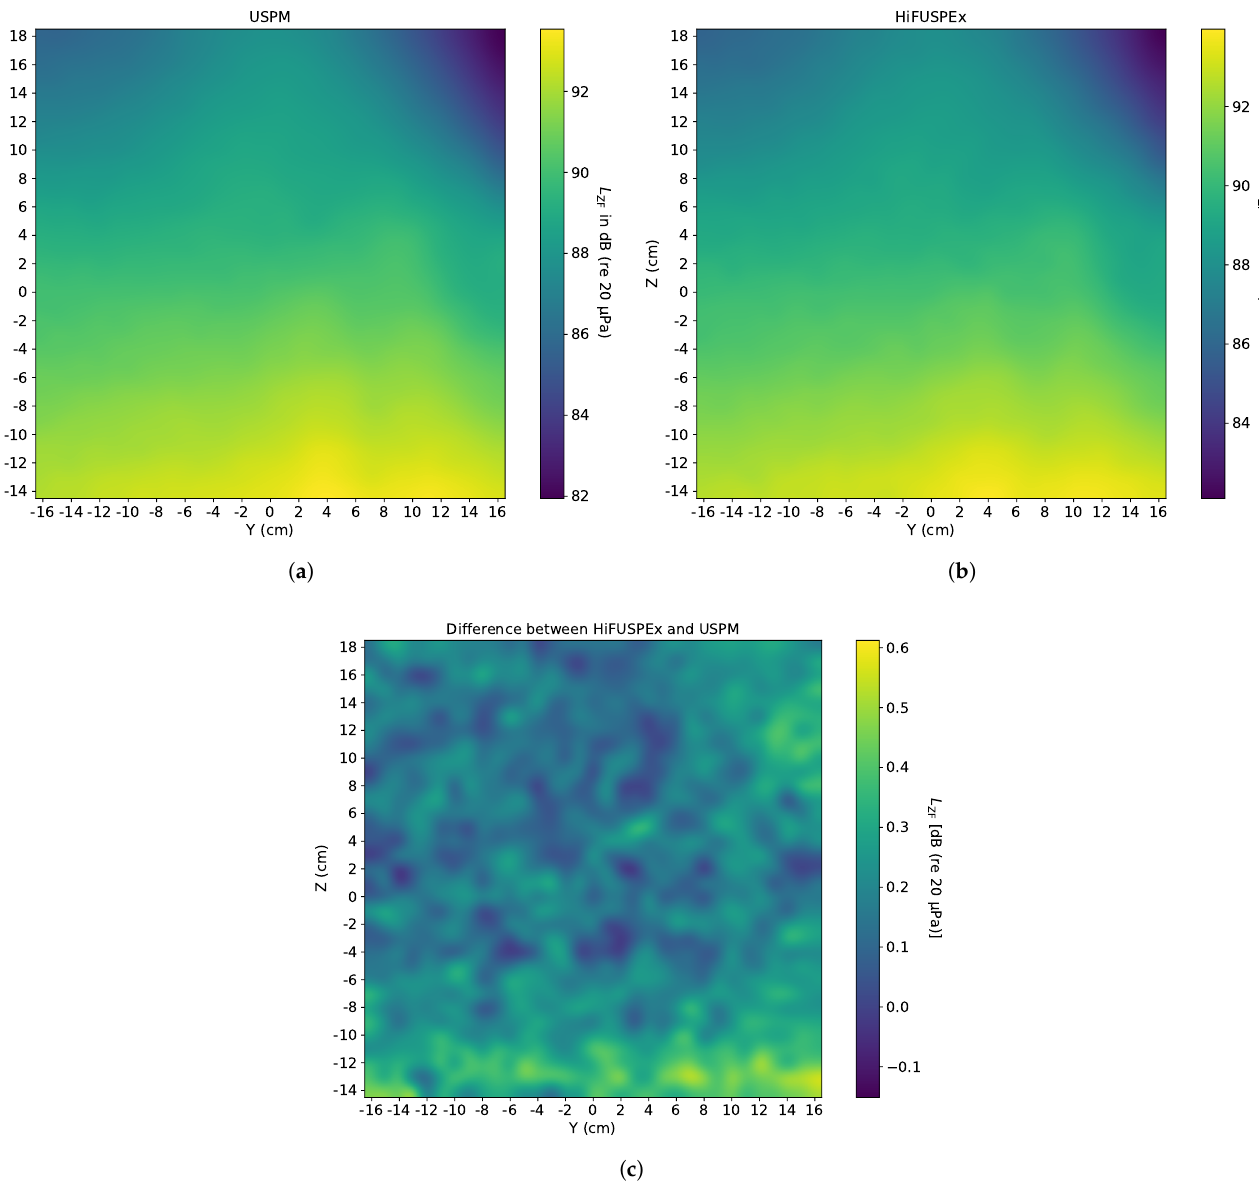
Figure 15. Sound fields within the scanning unit when an idealized signal of a compressed air gun was simulated. Results were obtained on the right-hand side with the artificial head in the sedentary position and without the protection grid mounted. The presented plots show the sound fields obtained for: ( a ) USPM; ( b ) HiFUSPEx; and ( c ) difference between the HiFUSPEx and the USPM. Please refer to Figure 10 for identification of zy